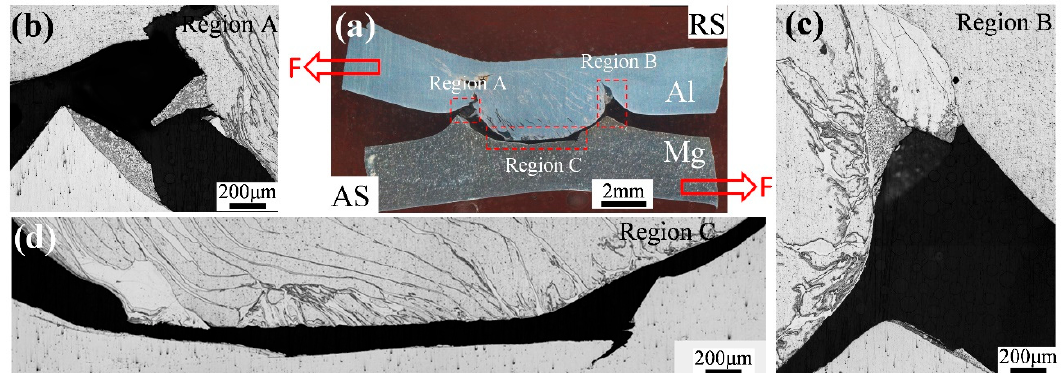
Figure 12. Macro- and micro-structures of the cross section of the failure joint welded in Configuration Al-Mg at 700 rpm: ( a ) macro-structure; ( b ) hook; ( c ) cold lap; ( d ) bottom of the SZ.